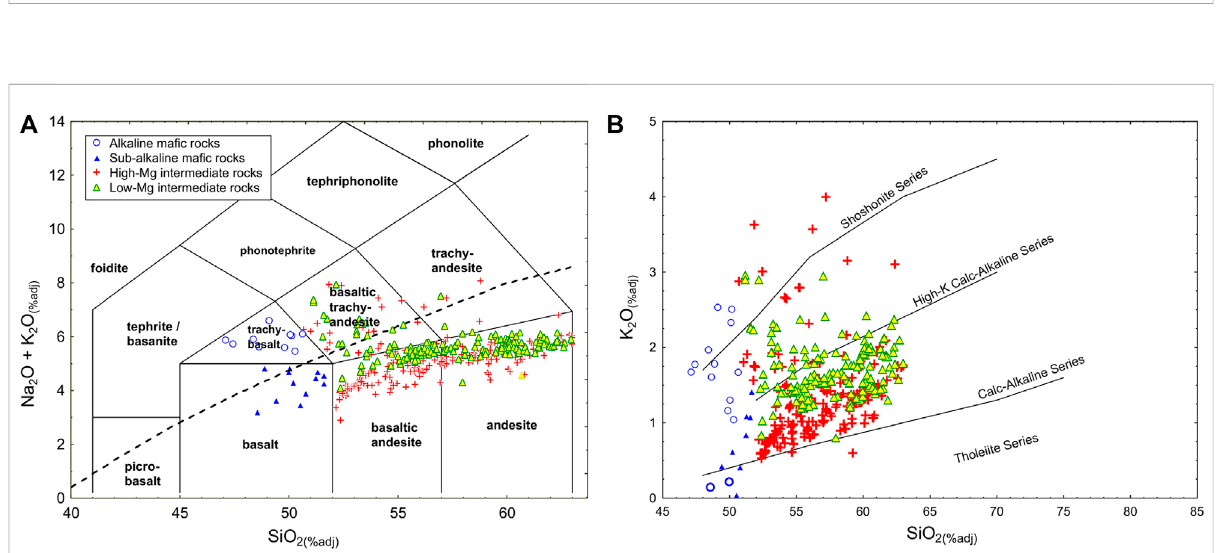
FIGURE 3 (A) Total alkali – silica classi fi cation diagram for the volcanic rocks from the MGVF (TAS; Le Bas et al., 1986). (B) Bivariate diagram of K 2 O (adj) – SiO 2(adj) diagram of Peccerrillo and Taylor